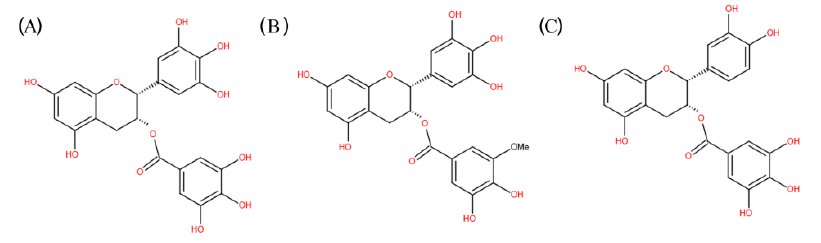
Figure 1. Chemical structure of EGCG ( A ), EGCG3’’Me ( B ), and ECG ( C